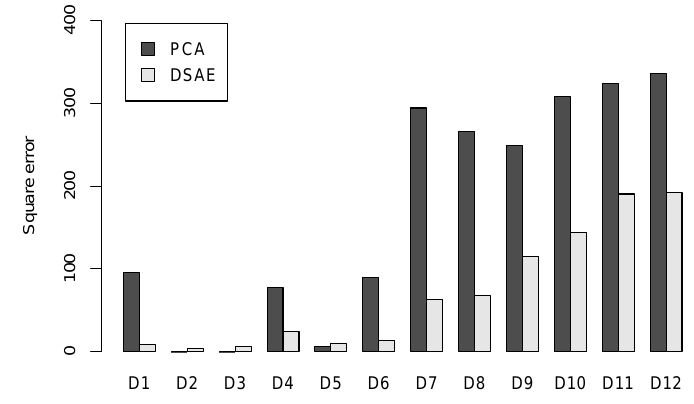
Figure 4. Averaged square error between windowing time-series data and reconstructed time-series data of datasets D1 to D12.